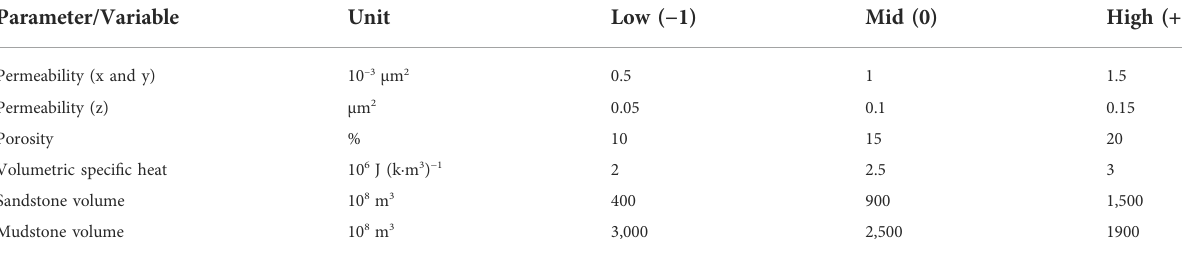
TABLE 1 Input parameters applied in the experimental design